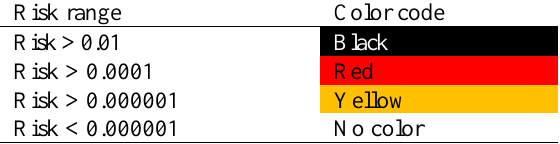
Table 2. LCR range and color codes for each